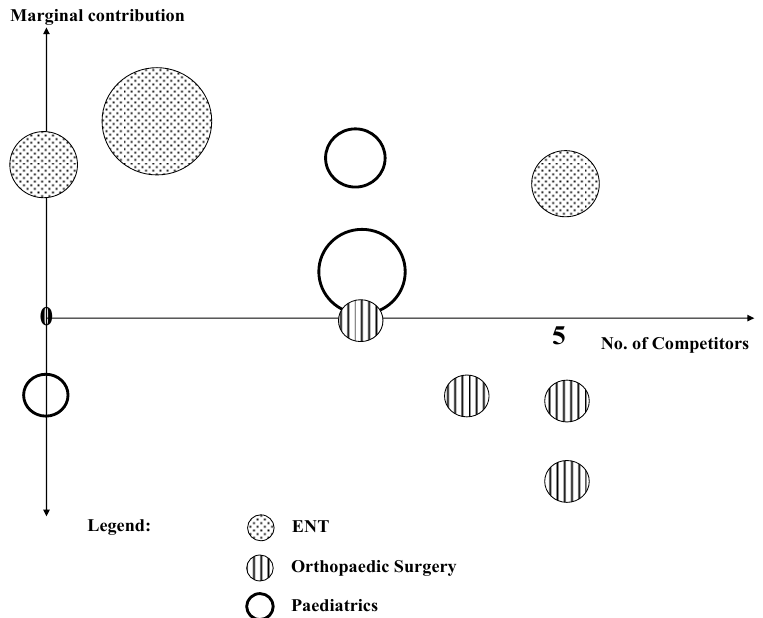
Figure 9 . Portfolio of a hospital. Source: own. Figure 9. Portfolio of a hospital. Source: